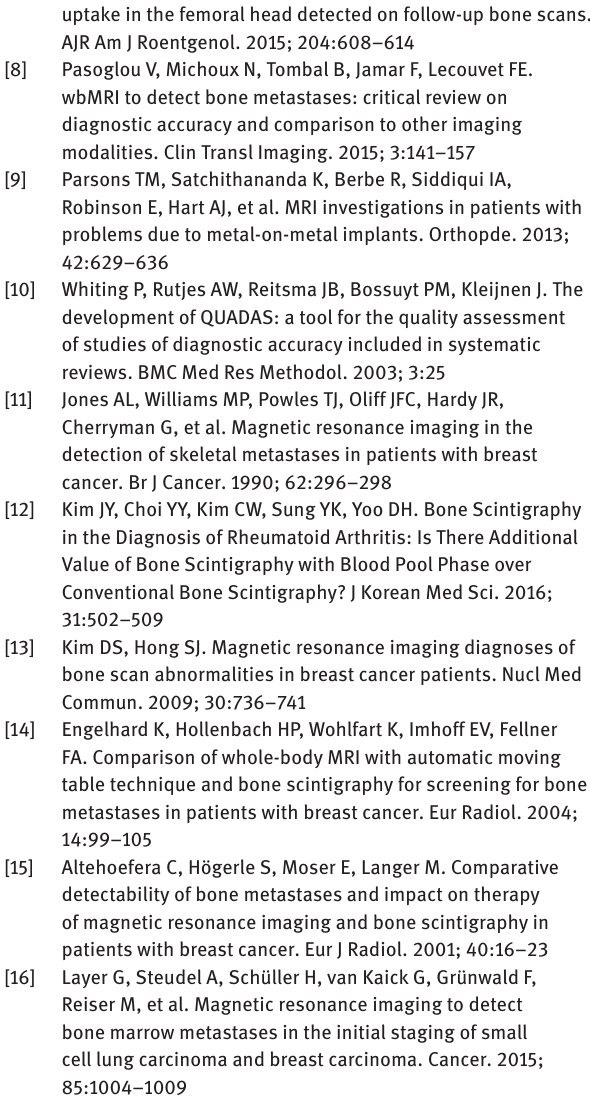
table technique and bone scintigraphy for screening for